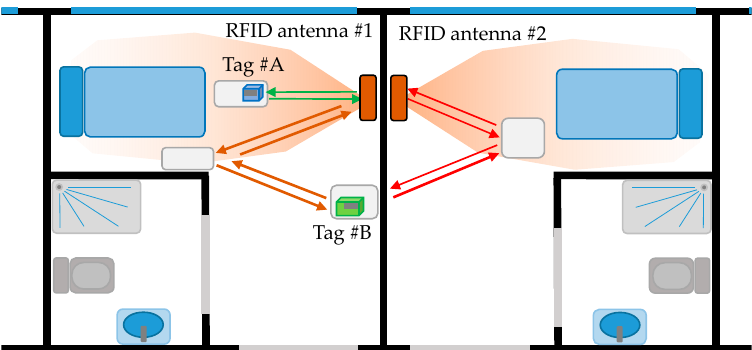
Figure 1. Example of non ‐ desired RFID tag read due to multipath ( in ‐ channel interference). Item tagged with tag #A is within the coverage area of RFID antenna #1, while item tagged with tag #B is located outside the coverage area. Green arrows represent desired interrogation/response. Brown arrows show non ‐ desired interrogation/response due to multipath affecting RFID antenna #1. Red arrows represent non ‐ desired interrogation/response due to multipath affecting RFID antenna #2 (in this case, interrogation and response RFID signals are partially attenuated when passing through the wall).